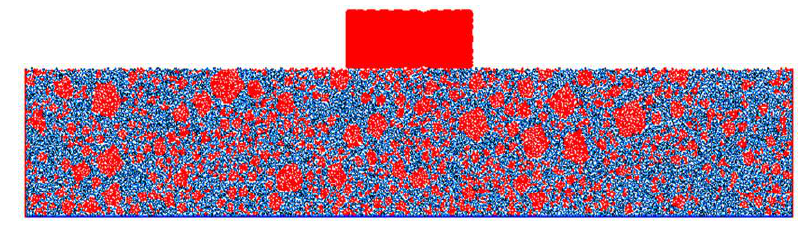
Figure 7. Establishing steps of the model.